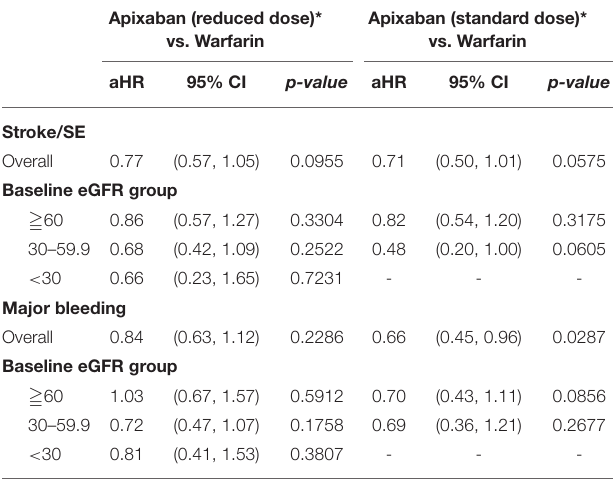
TABLE 3 | Study outcomes by apixaban dose. Apixaban (reduced dose)* vs.